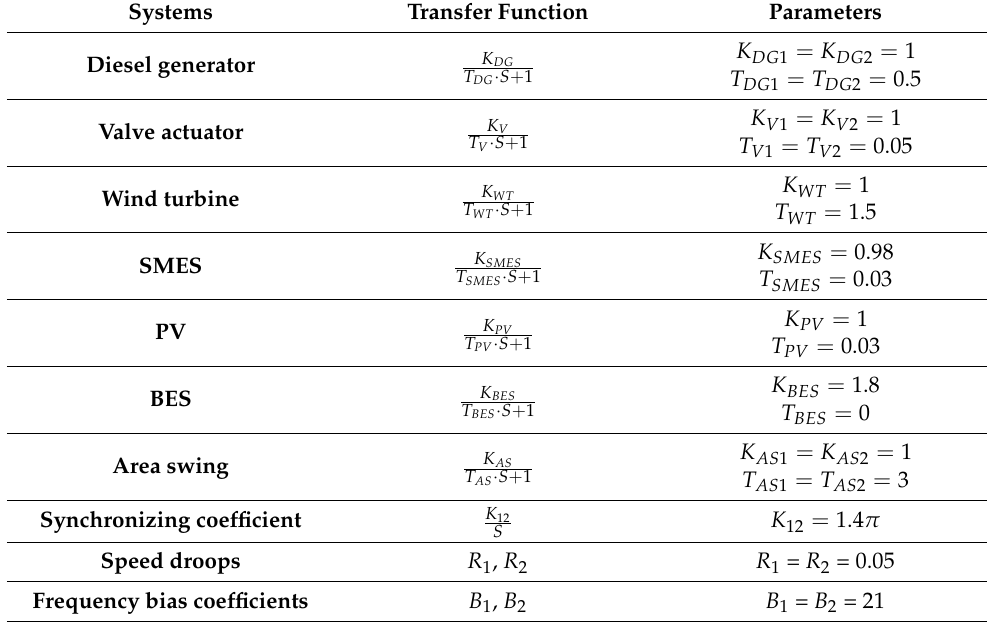
Table 1. Values for model parameters